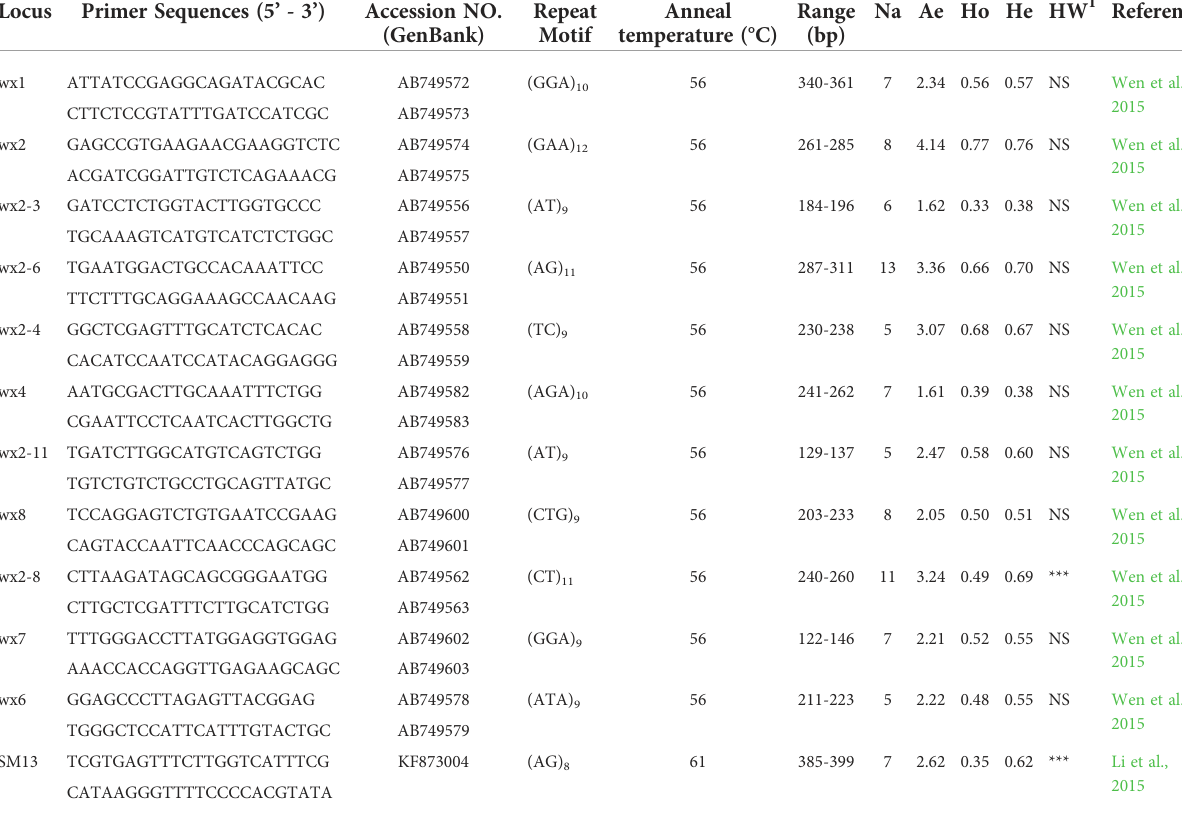
TABLE 1 Primer information and characteristics of 12 microsatellite markers were evaluated using all samples in the present study. Locus Primer Sequences (5 ’ - 3 ’